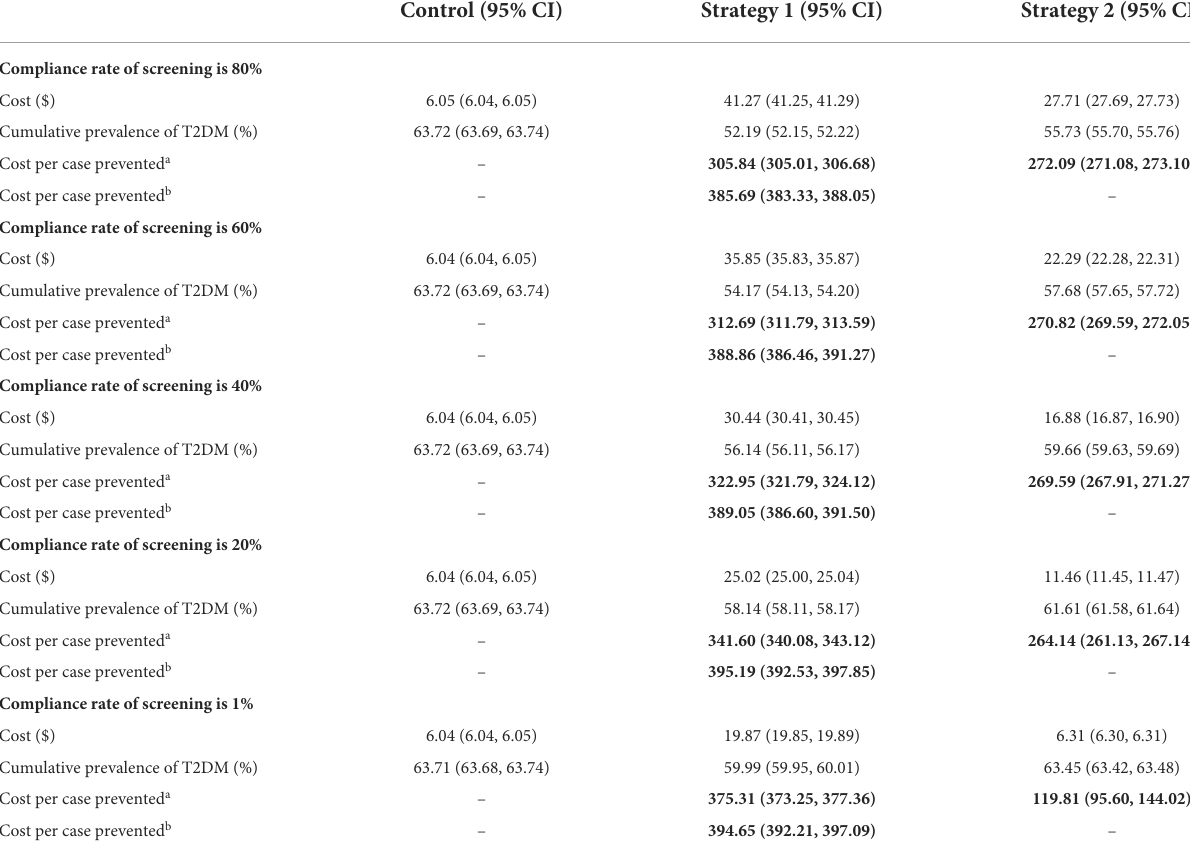
TABLE 3 Sensitivity of clinical and economic data to different compliance rates of